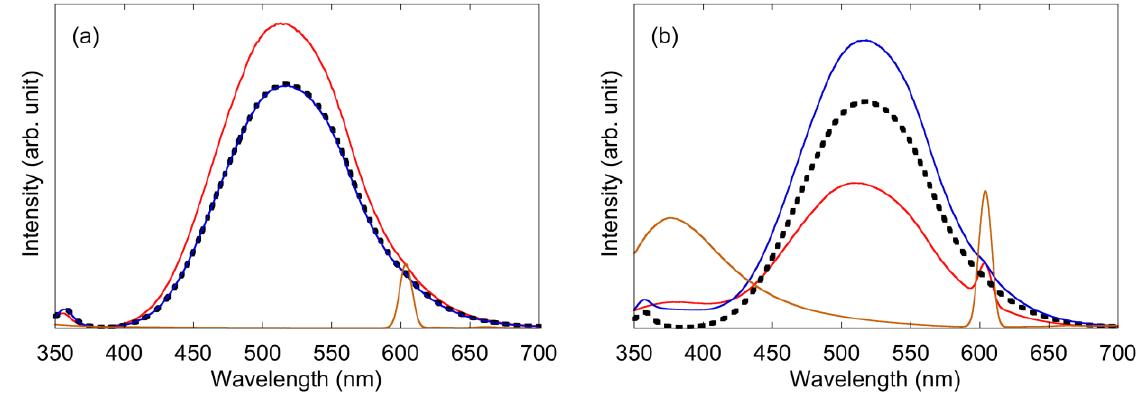
Figure 4. PL spectra of the ZnO nanoparticle solution with an excitation wavelength of 300 nm: ( a ) PEG was added to the solution; ( b ) PVP was added to the solution. Black dotted line: polymer was not added to the solution. Red solid line: polymer was added before the synthesis of ZnO nanoparticles. Blue solid line: polymer was added after the synthesis. Brown solid line: data of only the polymer solution.